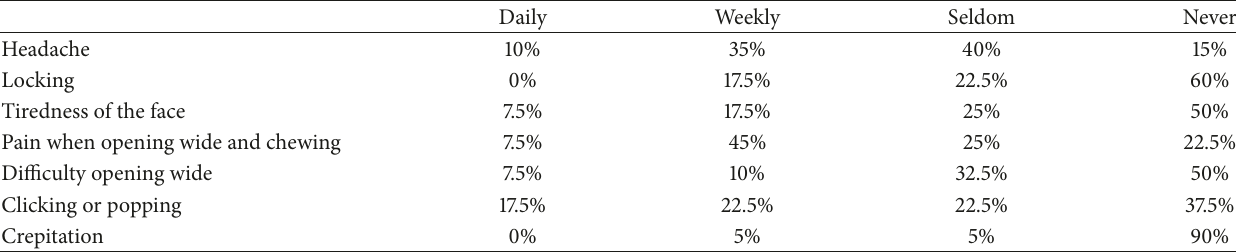
Table 5: Frequency of certain symptoms in the case